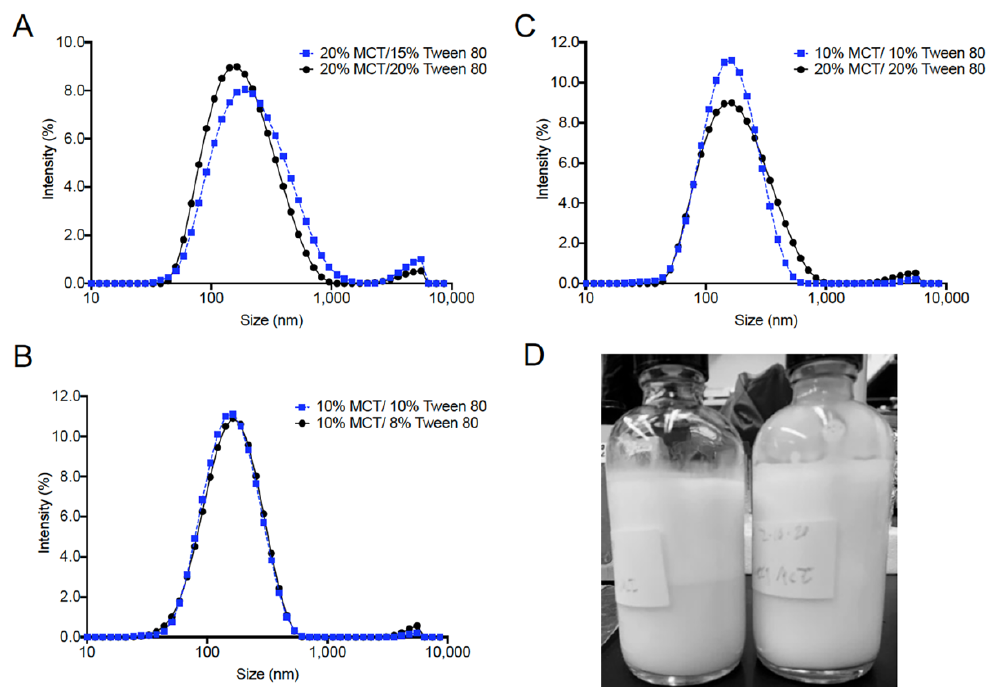
Figure 3. Nanoemulsions droplet size comparison for varied nanoemulsion compositions during pre-formulation studies. ( A ) 20% MCT oil/20% Tween 80 vs. 20% MCT oil/15% Tween 80; ( B ) 10% MCT oil/10% Tween 80 vs. 10% MCT oil/8% Tween 80; ( C ) 10% MCT oil/10% Tween 80 vs. 20% MCT oil/20% Tween 80 compositions; and ( D ) visual inspection of select nanoemulsions during pre-